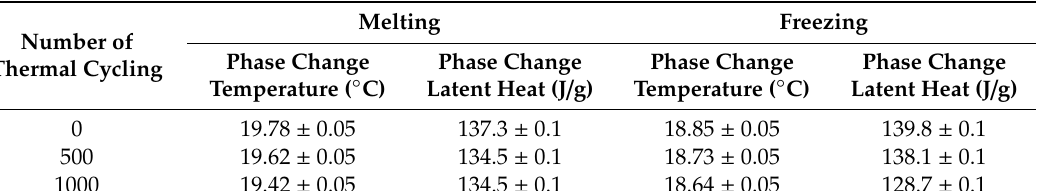
Figure 6. The CA–MA / EG thermal conductivity variations with the packing density. Figure 6. The CA–MA/EG thermal conductivity variations with the packing density. Table 4. Heat performances of CA–MA and CA–MA / EG.